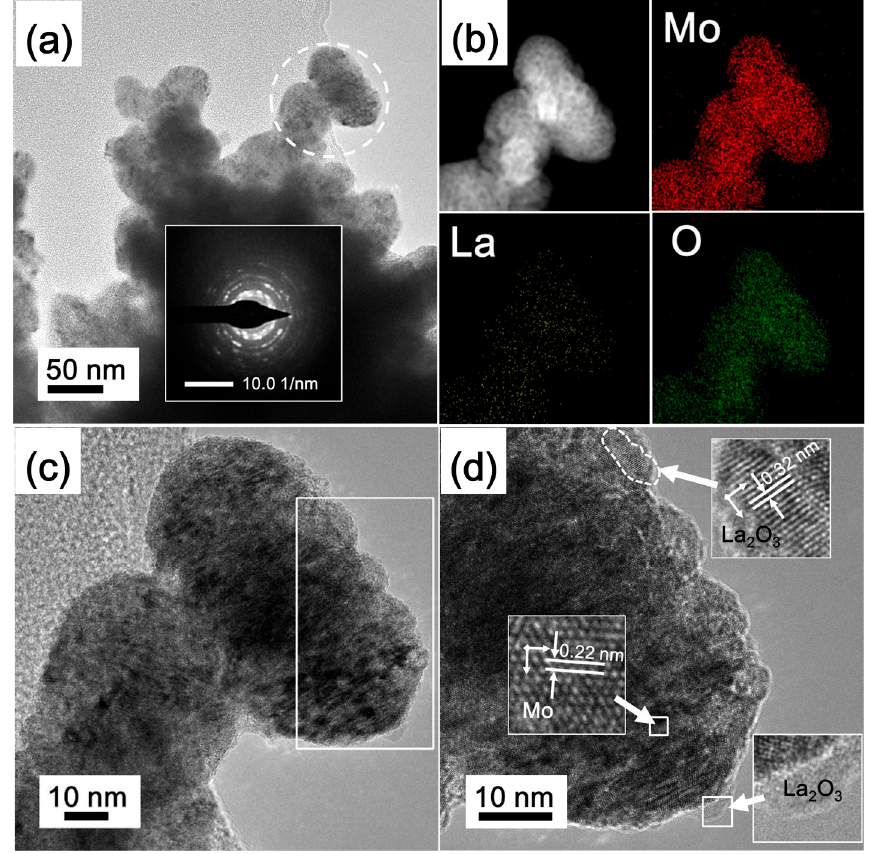
Figure 10. ( a ) TEM, ( b ) elemental mapping, ( c , d ) HRTEM images of La 2 O 3 doped Mo nanopowders (LM9 sample); the inset of ( a ) shows the corresponding SAED pattern; the insets of ( d ) show the lattice fringes of metallic Mo and La 2 O 3 .